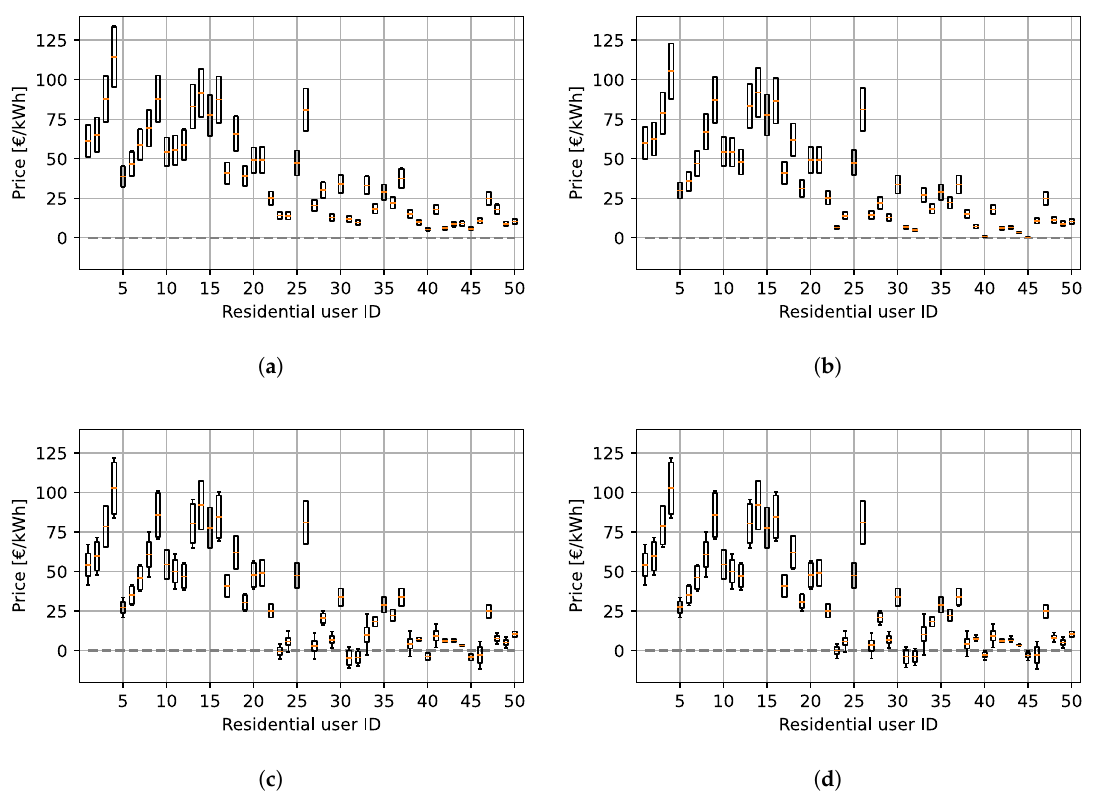
Figure 6. Residential users payment distribution in each case, considering Price 1. ( a ) Case 1. ( b ) Case 2. ( c ) Case 3. ( d ) Case 4.